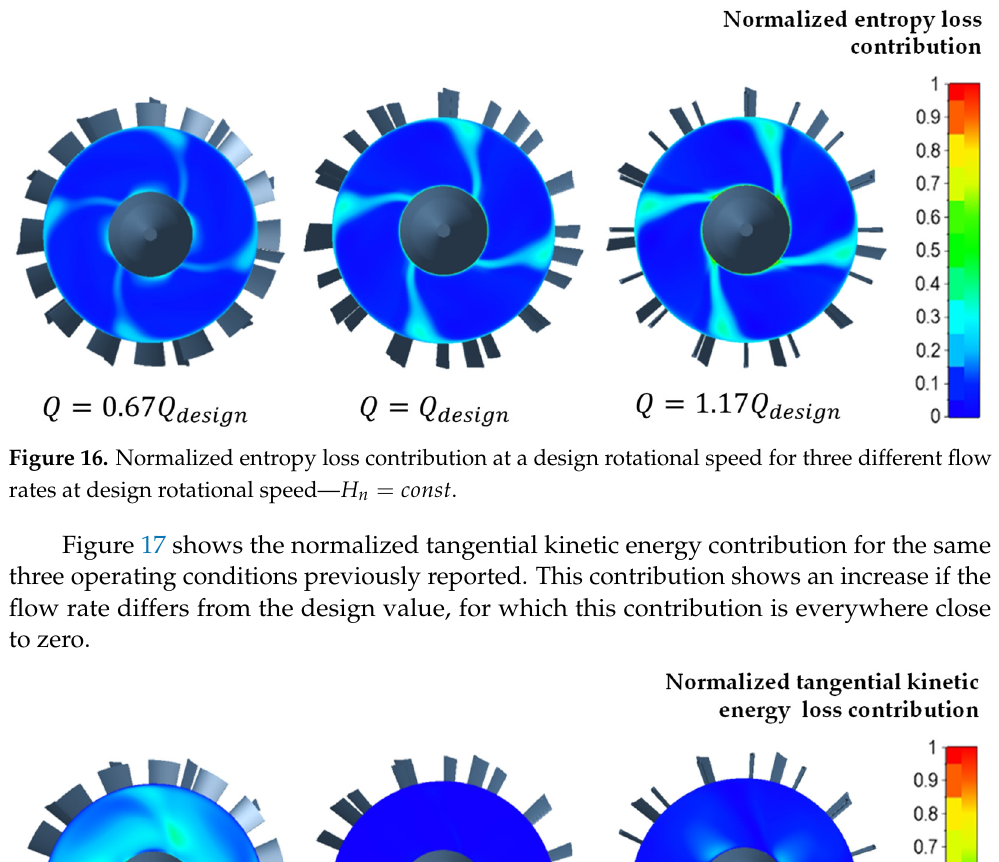
17 of 22 ( b ) Figure 15. Guide vane opening angle law as a function of 𝑄 𝑄 (cid:3031)(cid:3032)(cid:3046)(cid:3036)(cid:3034)(cid:3041) ⁄